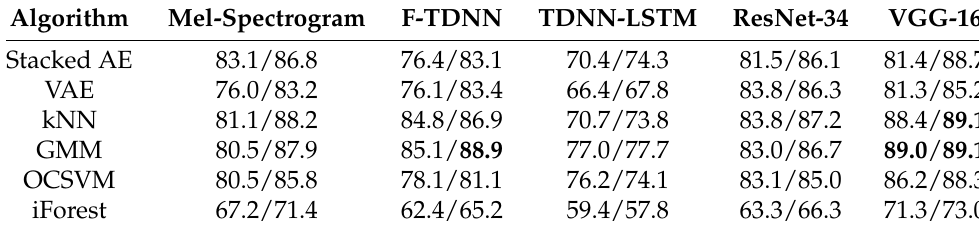
Table 2. The Average F1/AUC Scores of AND on ESC-10